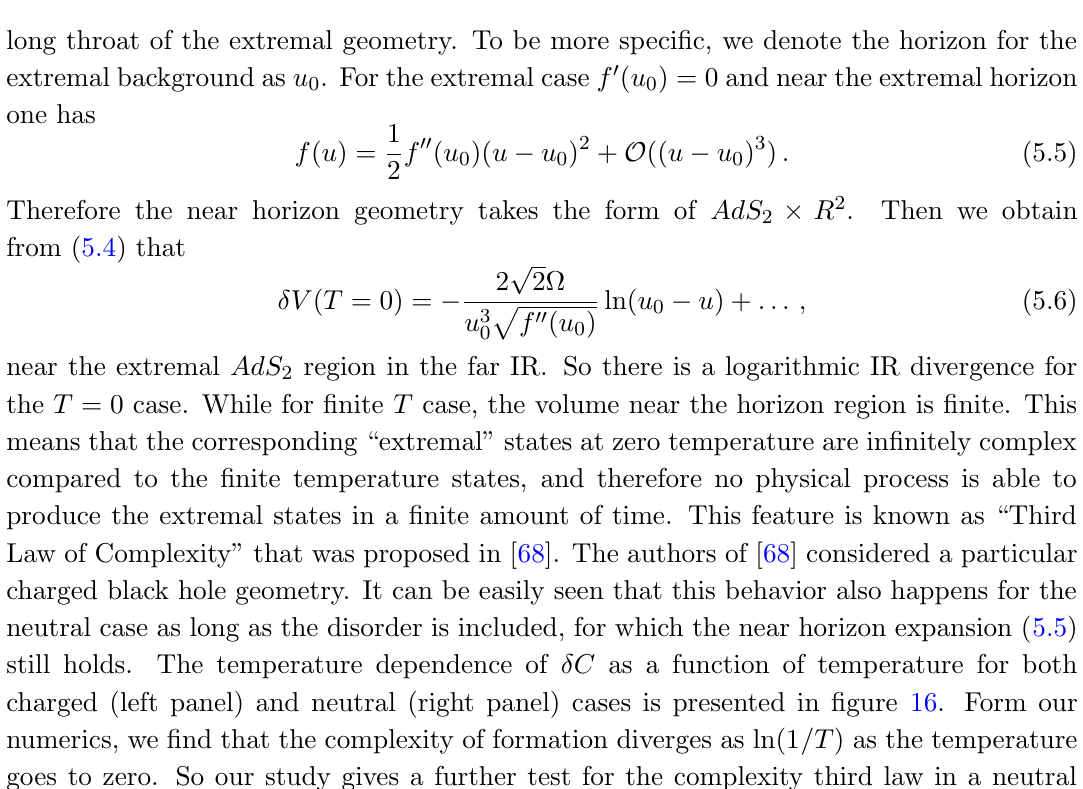
Figure 15 . Complexity of formation under the variation of (cid:11) for the Exponential model with (cid:20) = 1 = 6 (left) and the Linear model with K = (cid:0) 1 = 6 (right). Di(cid:11)erent colors correspond to di(cid:11)erent temperatures. For other parameters we choose (cid:26) = 1 and B =